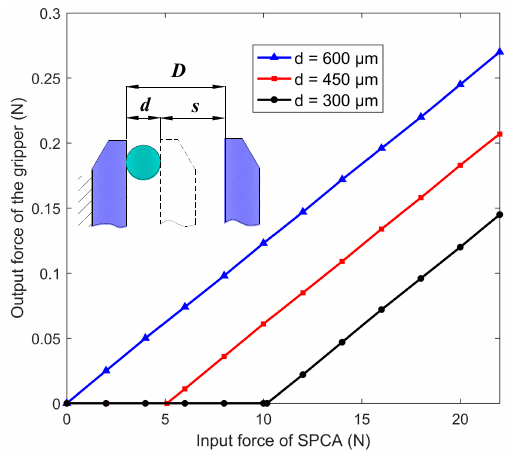
Figure 6. FEA diagram of the microgripper: ( a ) FEA settings, ( b ) deformation pattern and ( c ) stress pattern. Figure 7. SPCA input force versus the output force of the gripper.